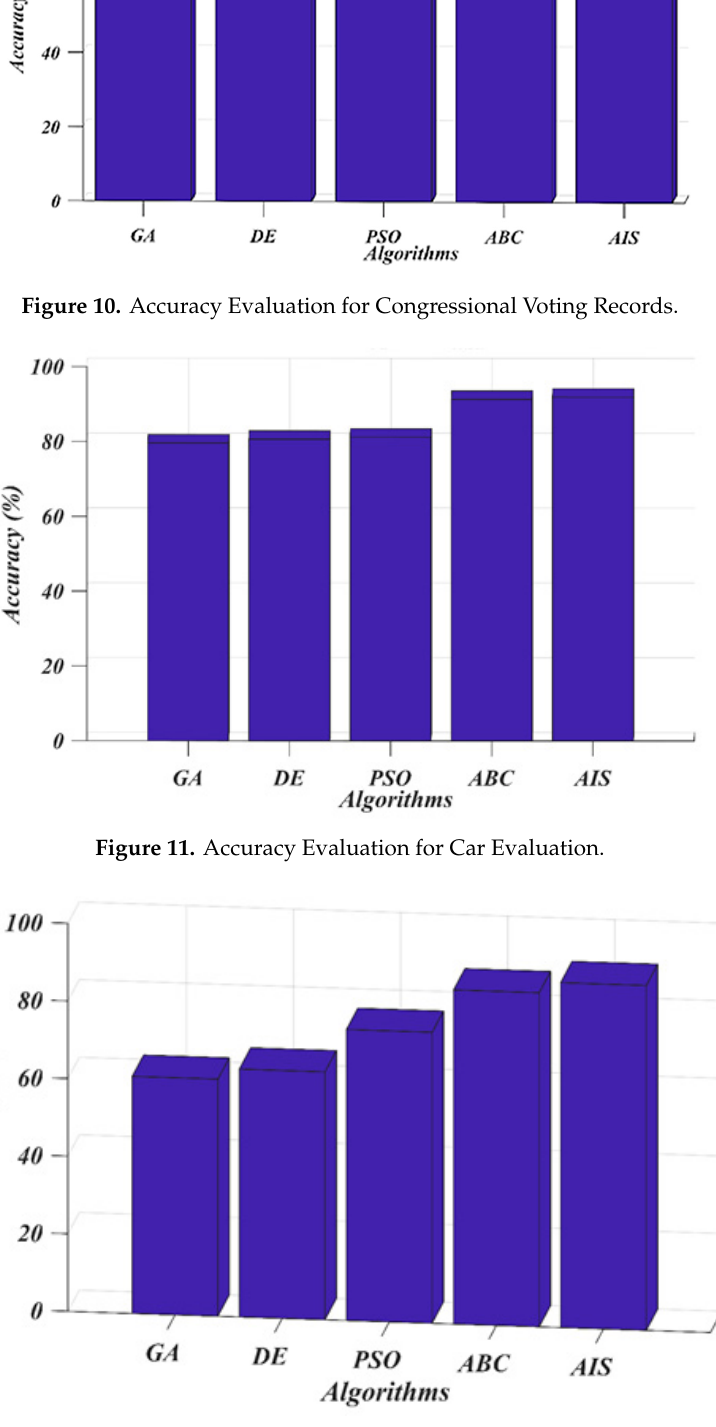
Figure 12. Accuracy Evaluation for Postoperative Patient.